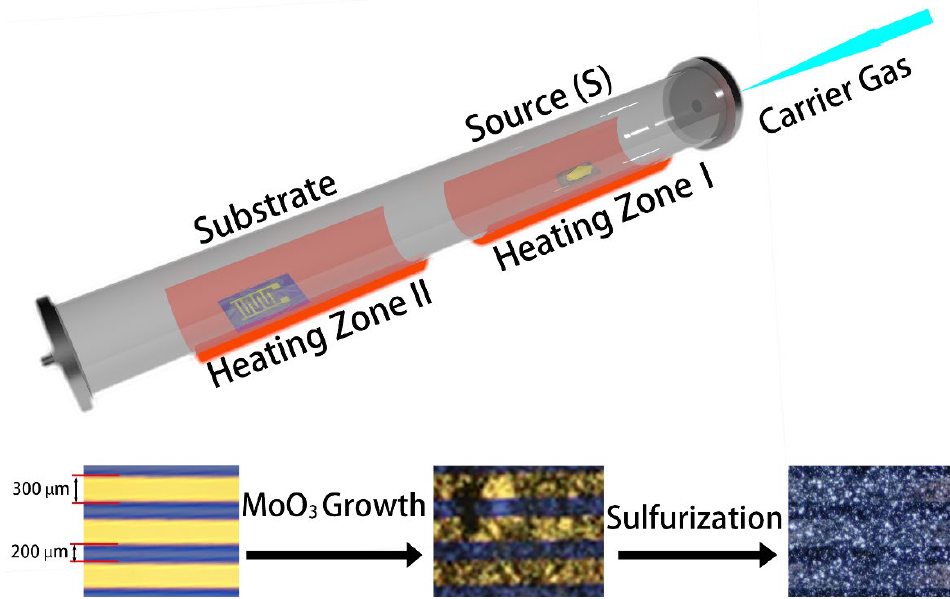
Figure 1. Above: schematic illustration of the post-sulfurization process for MoO 3 nanoribbons, the SiO 2 /Si substrate with pre-patterned interdigital electrodes. Below: the optical images of the device SiO 2 /Si substrate with pre-patterned interdigital electrodes. Below : the optical images of the device before and after MoO 3 synthesis and subsequent sulfurization. before and after MoO 3 synthesis and subsequent